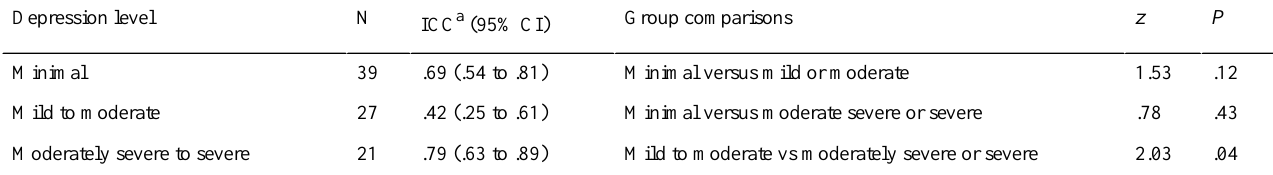
Table 2. IMS-12 intraclass correlations.